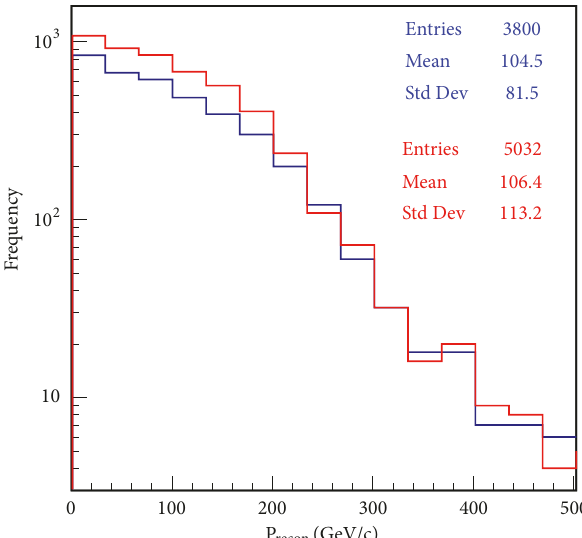
Figure 11: Differential muon flux(red line 𝜇 + and blue line 𝜇 − ) at the ICAL detector as a function of reconstructed muon momentum after passing through the rock.